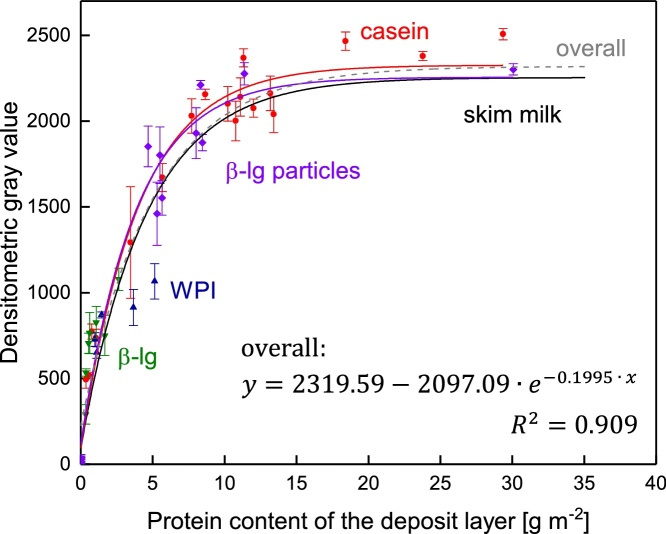
Color intensity of CBB stained deposits of varying protein sources as a function the protein quantity (skim milk data points were removed for better clarity). Standard deviation shows the deviation in the densitometric gray value of three measurement points on the membrane with a size of 76 mm2 each.